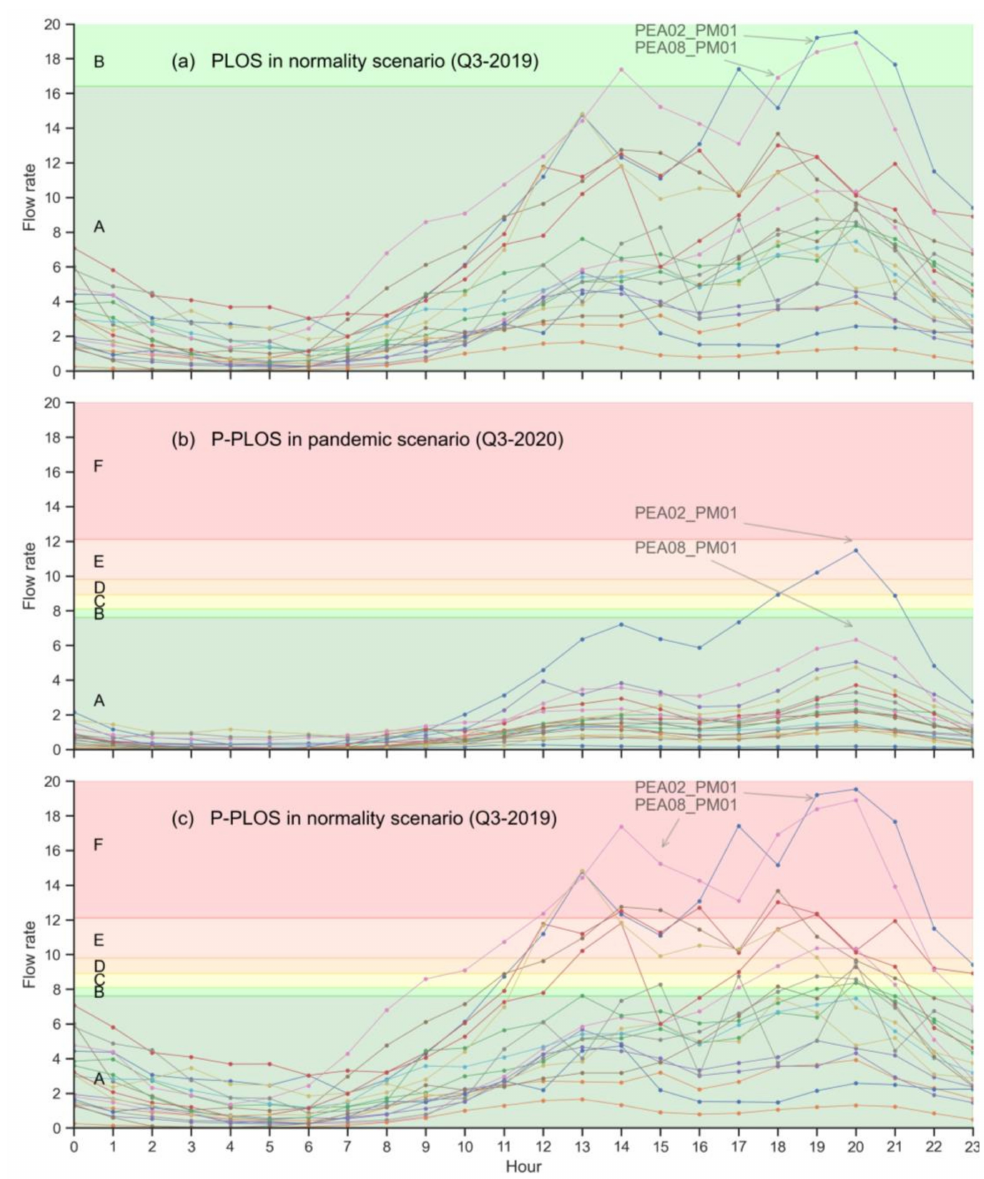
Figure 8. Comparison of the pedestrian levels of service in normality scenario ( a ), pandemic scenario ( b ) and P-PLOS in normality scenario ( c